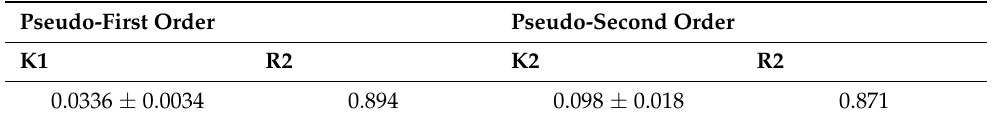
Table 1. Pseudo-first-order and pseudo-second-order kinetic parameters K 1 (min − 1 ) and K 2 (g mg − 1 min − 1 ) for cisplatin sorption on Si-DTC at 25 ◦ C.